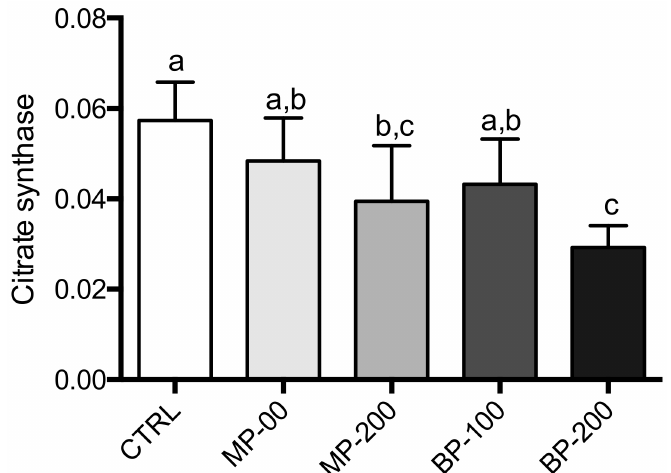
Figure 4. Citrate synthase activities in mitochondria isolated from testes of F1 generation. The results are M ± SD of 7–10 independent experiments performed in duplicate and expressed as nmol 2-nitro-5-thiobenzoic acid / min / mg protein. The values marked with the same letter are not statistically significant between groups as determined by the Tukey’s post hoc test ( p < 0.05).